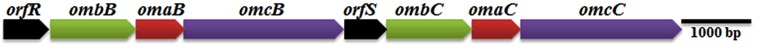
The orfR gene clusters of Geobacter sulfurreducens PCA. The genes encoding transcriptional factors, porin-like outer-membrane proteins, the periplasmic c-type cytochromes and the outer-membrane c-type cytochromes are labeled in black, green, red, and purple, respectively.